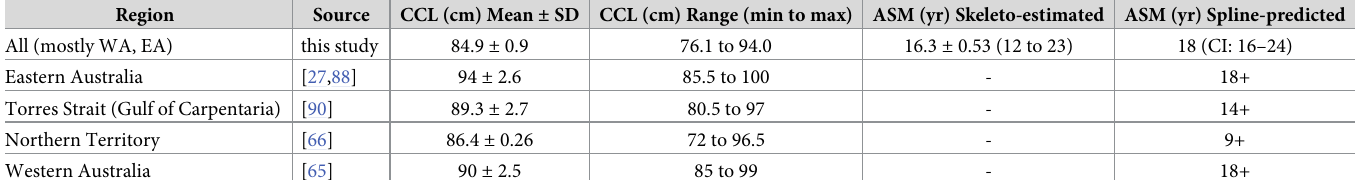
Table 2. Flatback maturation size and